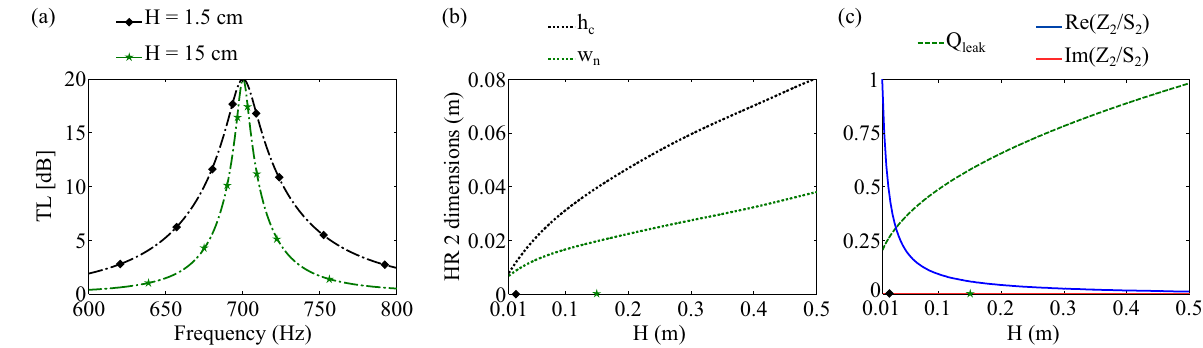
Figure 2. Overview of the TMM prediction of the HR 2 behavior mounted in a rectangular section duct and 1.5 cm and for H 15 cm. ( b ) Optimized HR 2 cavity optimized for TL (700 Hz) = 20 dB. ( a ) TL( f ) for H = = height, h c , and neck width, w n . ( c ) Optimized HR 2 behavior at 700 Hz in terms of normalized leakage quality factor, Q leak , and in terms of normalized surface impedance, Z 2 / S 2 . The diamond and star markers on the abscissa axis of ( b ) and ( c ) indicate that H is equal to 1.5 cm and 15 cm, respectively.